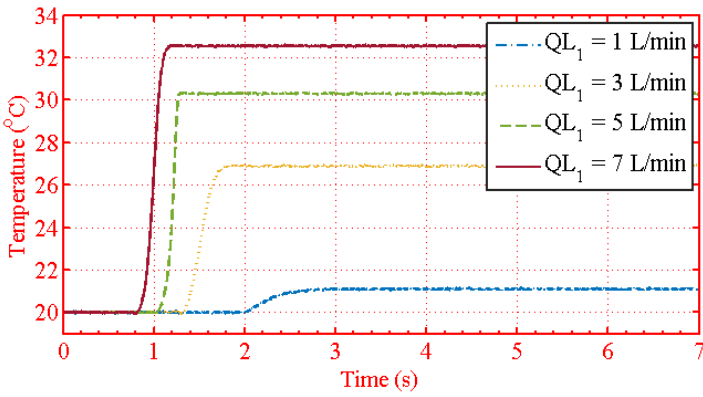
Figure 28. The output temperature in cold fluid with QL 2 = 5